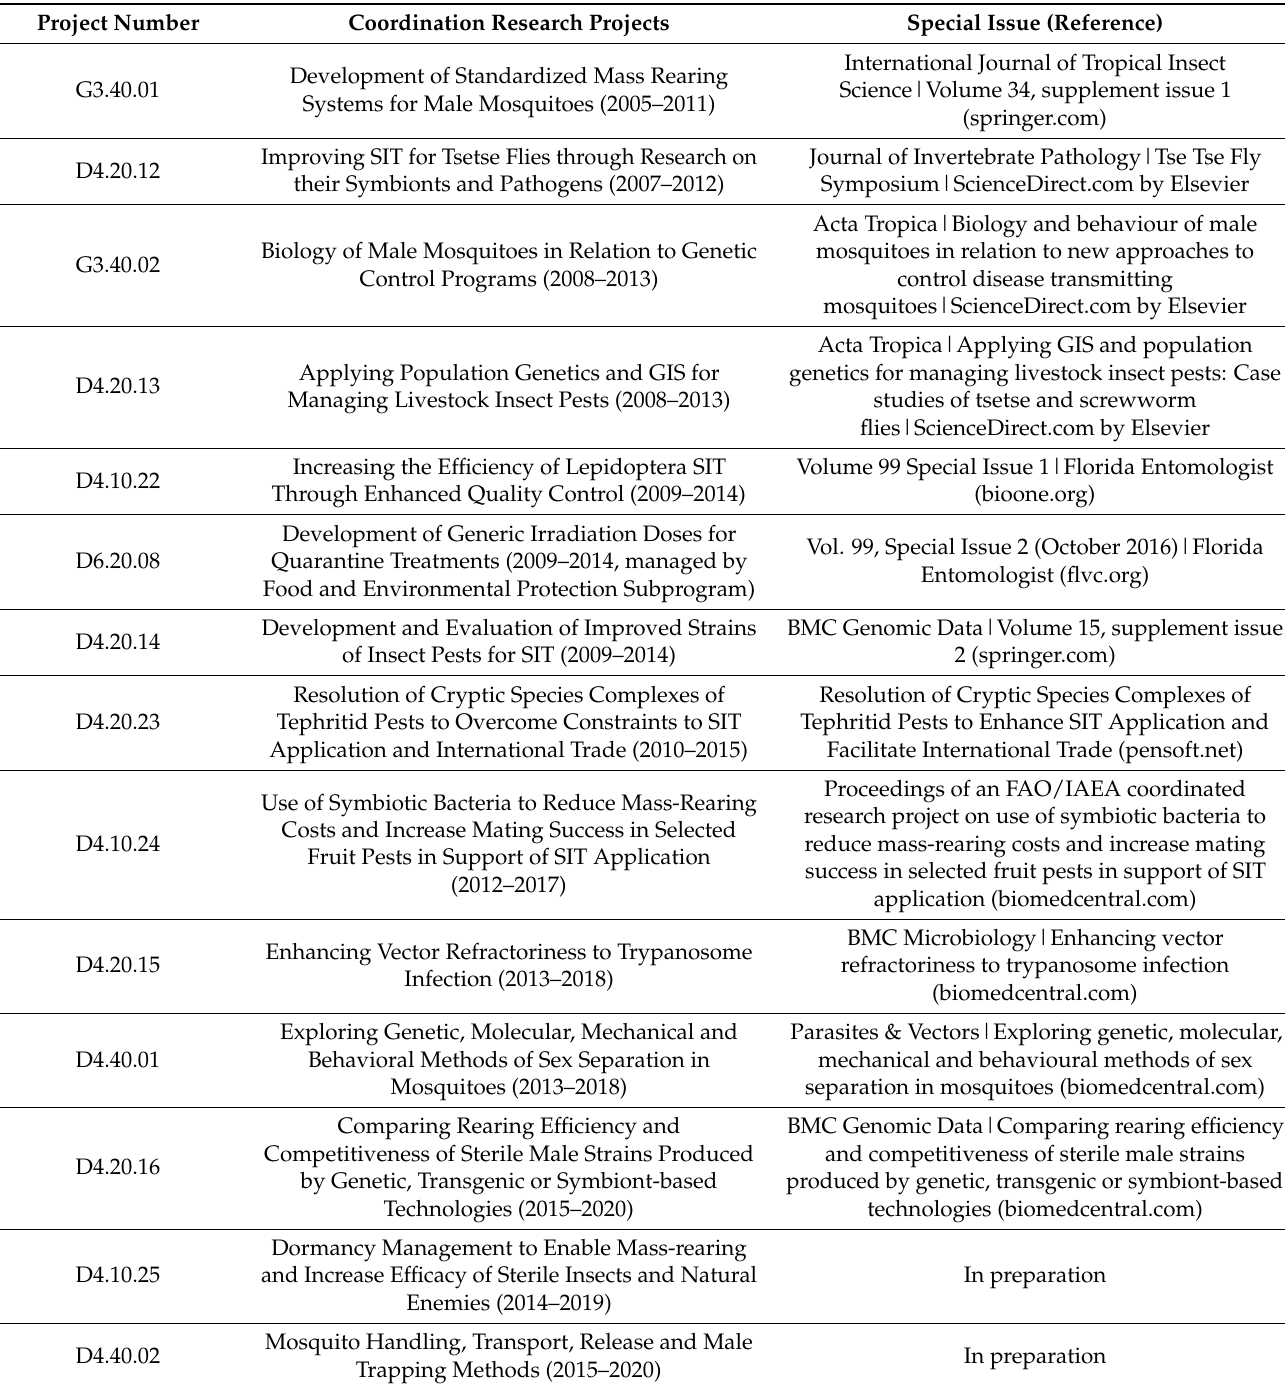
Table 1. Coordinated research projects that have been implemented in the last 10 years, and special issues that were published to disseminate the